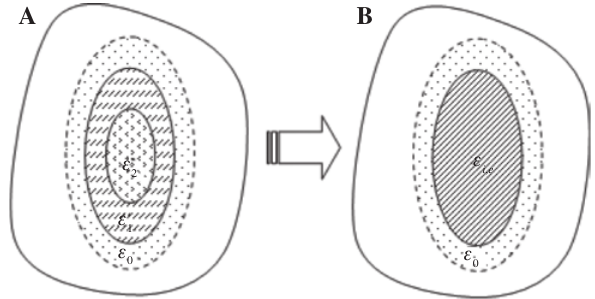
Figure 3: Scheme of a mixture with bilayer ellipsoids oriented randomly.